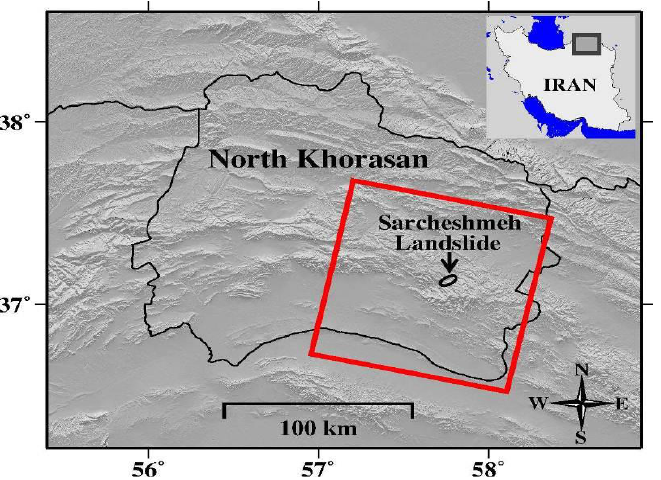
Figure 4. The study area in northeastern Iran (upper inset); the red box delineates the area covered by the Envisat frame in this study. Approximate location of the Sarcheshmeh landslide is specified by a black